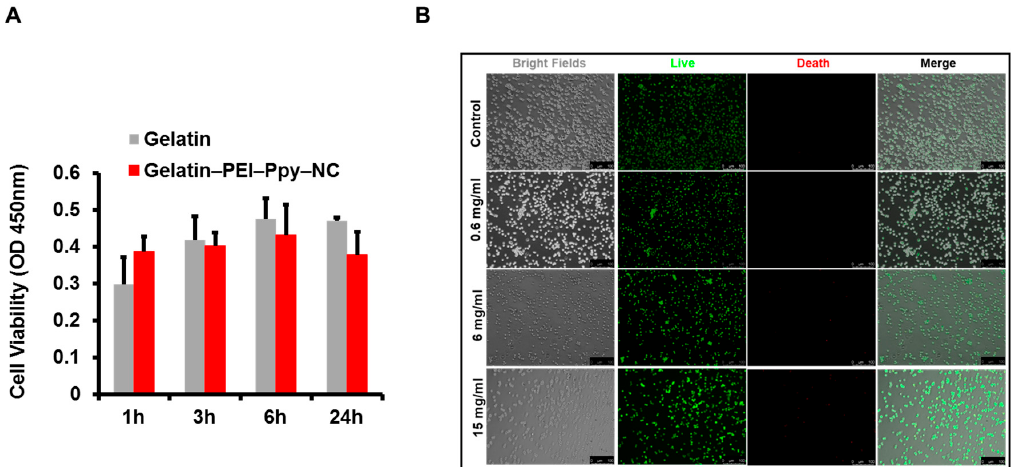
Figure 6. ( A ) Results of the MTT cytotoxicity assay of gelatin ‒ PEI–Ppy ‒ NC hydrogel ( n = 3); (NS–non significant); ( B ) Results of cellular interaction behavior by live/dead staining test after incubating